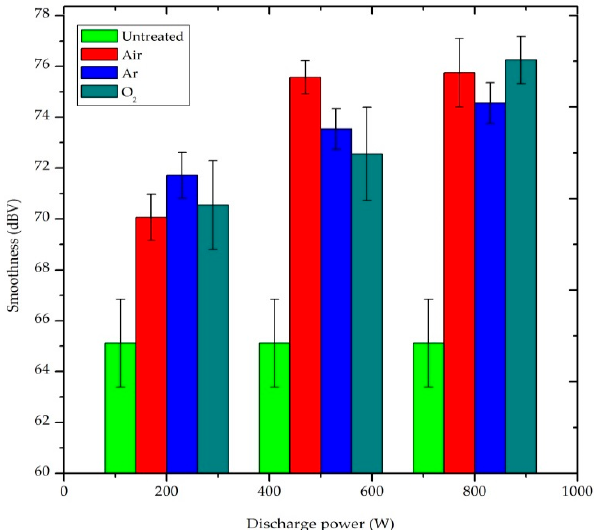
Figure 8. Effect of plasma treatment on the smoothness property of P/C blend fabric.